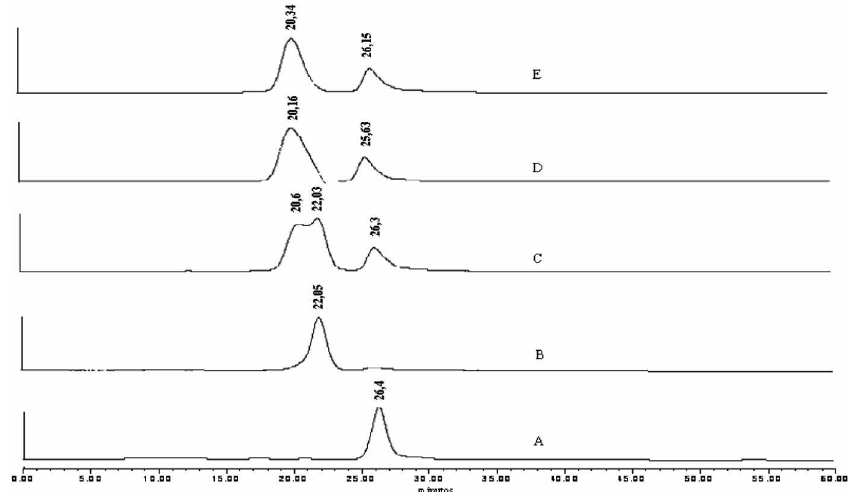
Figure 1 - SE HPLC chromatogram profile with UV 265 detection (A) B-MORF; (B) SA; (C) SA/B-MORF (1:1); (D) SA/B-MORF (1:2); (E) SA/B - MORF